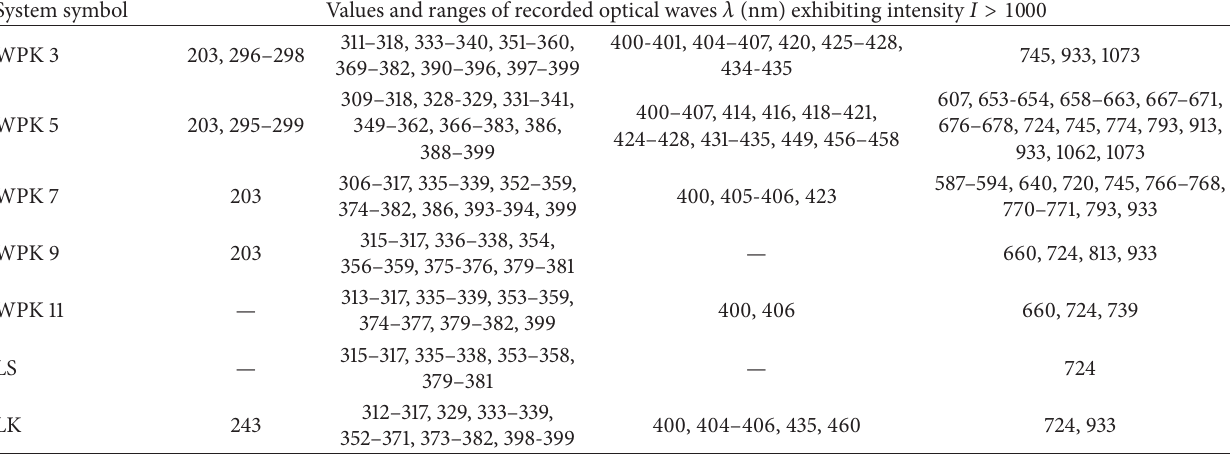
Figure 20: Comparison of RMSE (a) and SSE (b) obtained in model M2 for all the recorded signals. Table 6: Comparison of the dominating wavelengths present in light emission of value 𝐼 > 1000 for all tested dielectrics and ceramic insulators. System symbol Values and ranges of recorded optical waves 𝜆 (nm) exhibiting intensity 𝐼 >